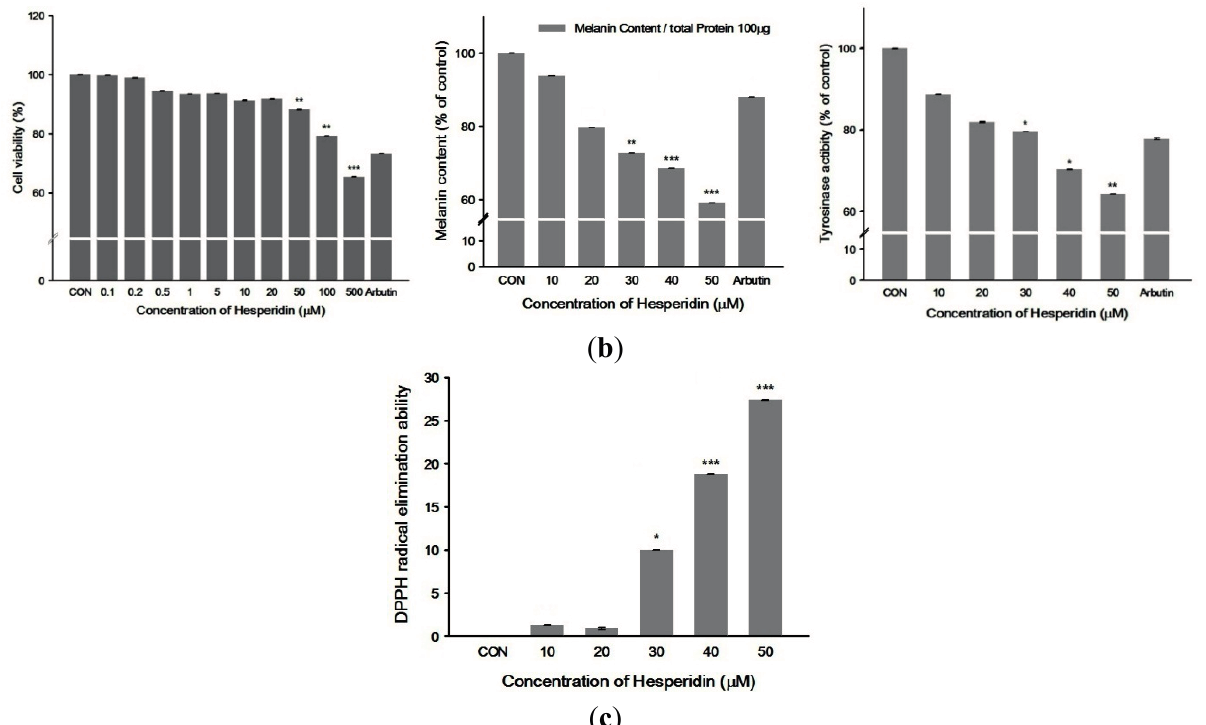
Figure 1. ( a ) Effect of hesperidin on normal human melanocyte viability and cellular melanin contents. Cells were exposed to hesperidin (0–50 μ M) and arbutin 50 mg/mL (positive control) for 72 h. Cell viability was determined by